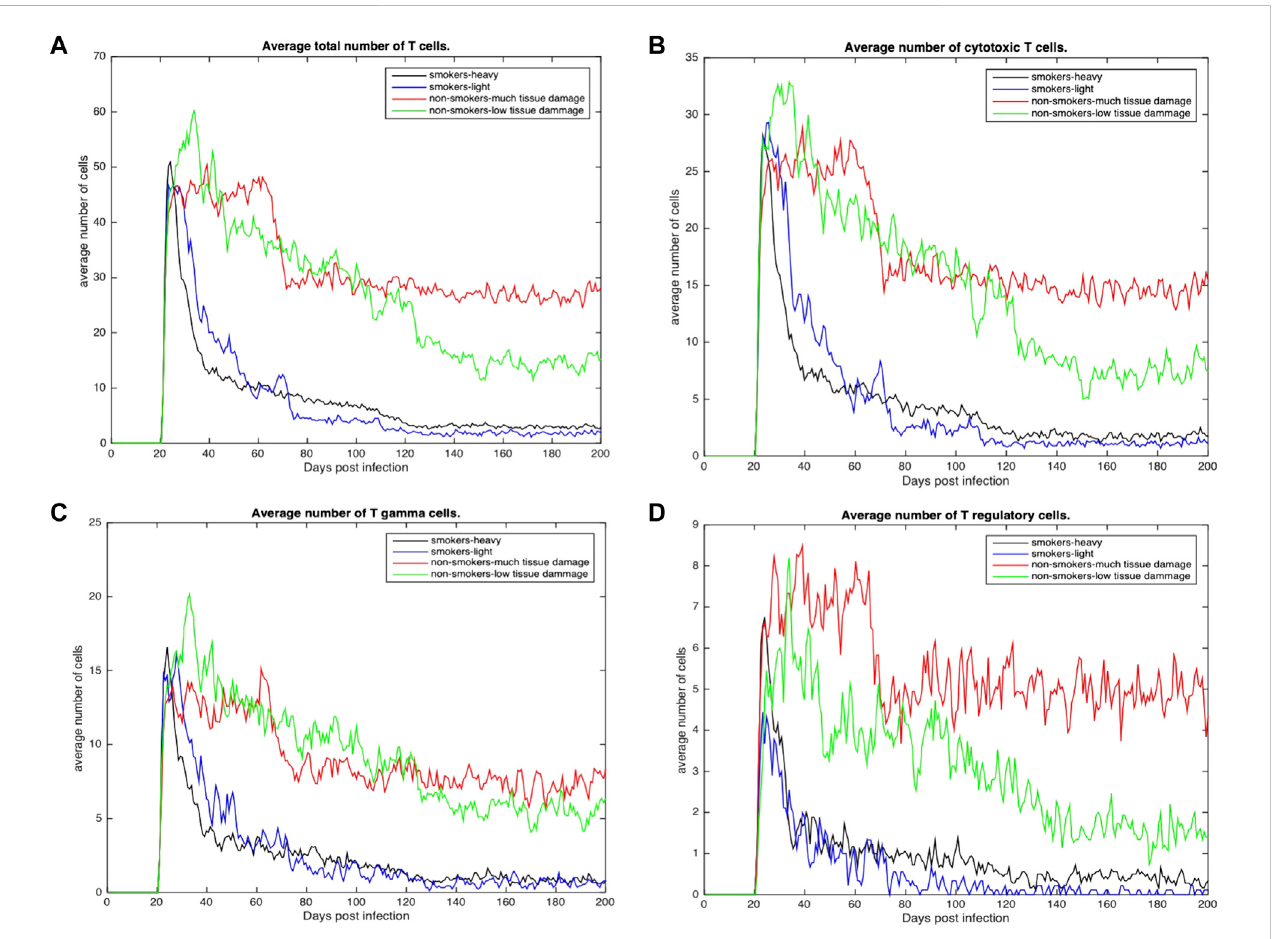
FIGURE 5 (A) AveragetotalnumberofTcellsrecruitedacrossallcategories (B) AveragetotalnumberofcytotoxicTcellsrecruitedacrossallcategories. (C) Average total number of γδ -T cells across all categories (D) Average total number of regulatory T cells across all